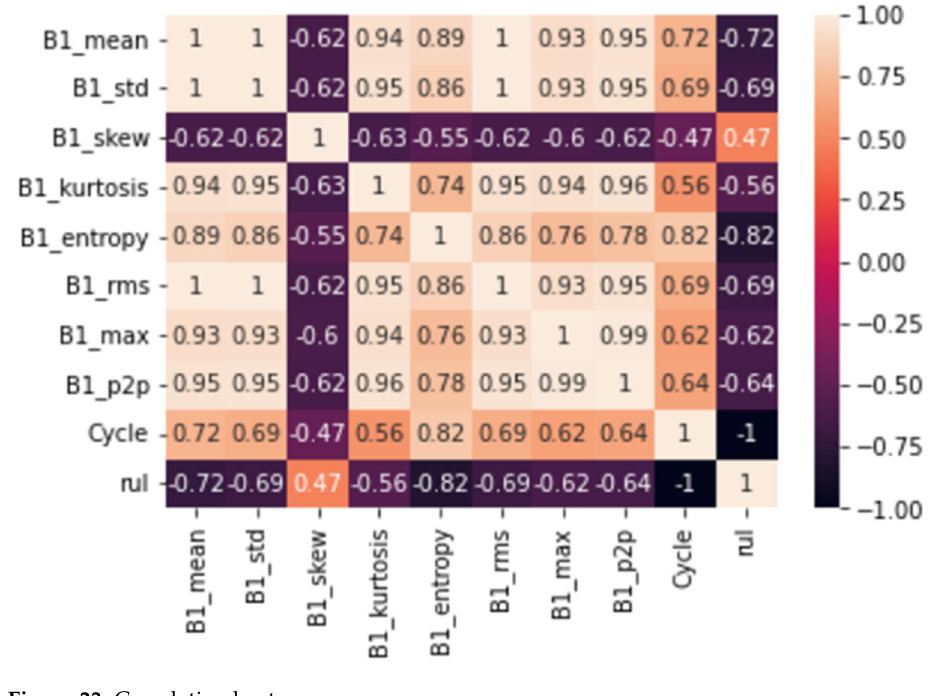
Figure 23. Correlation heatmap.